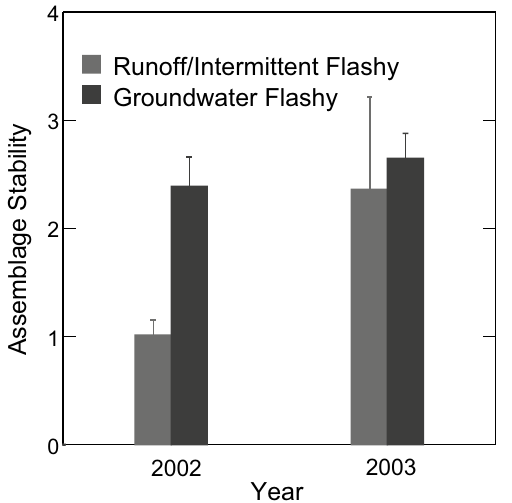
Figure 6. Mean (± SE) assemblage stability in Runoff/Intermittent Flashy and Groundwater Flashy streams in 2002 and 2003. Figure produced with SYSTAT